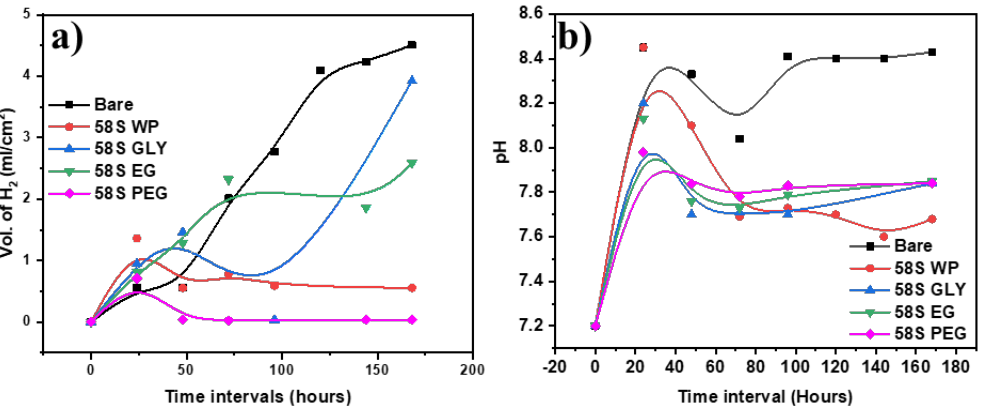
Figure 5. The results of hydrogen gas (H 2 ) evolution test. ( a ) pH variation for uncoated and ( b ) coated AZ31B alloys using different polyols as a function of immersion time in Hank ´ s solution at 37 ◦ C. Similar to H 2 evolution, the pH change was also monitored with the immersion